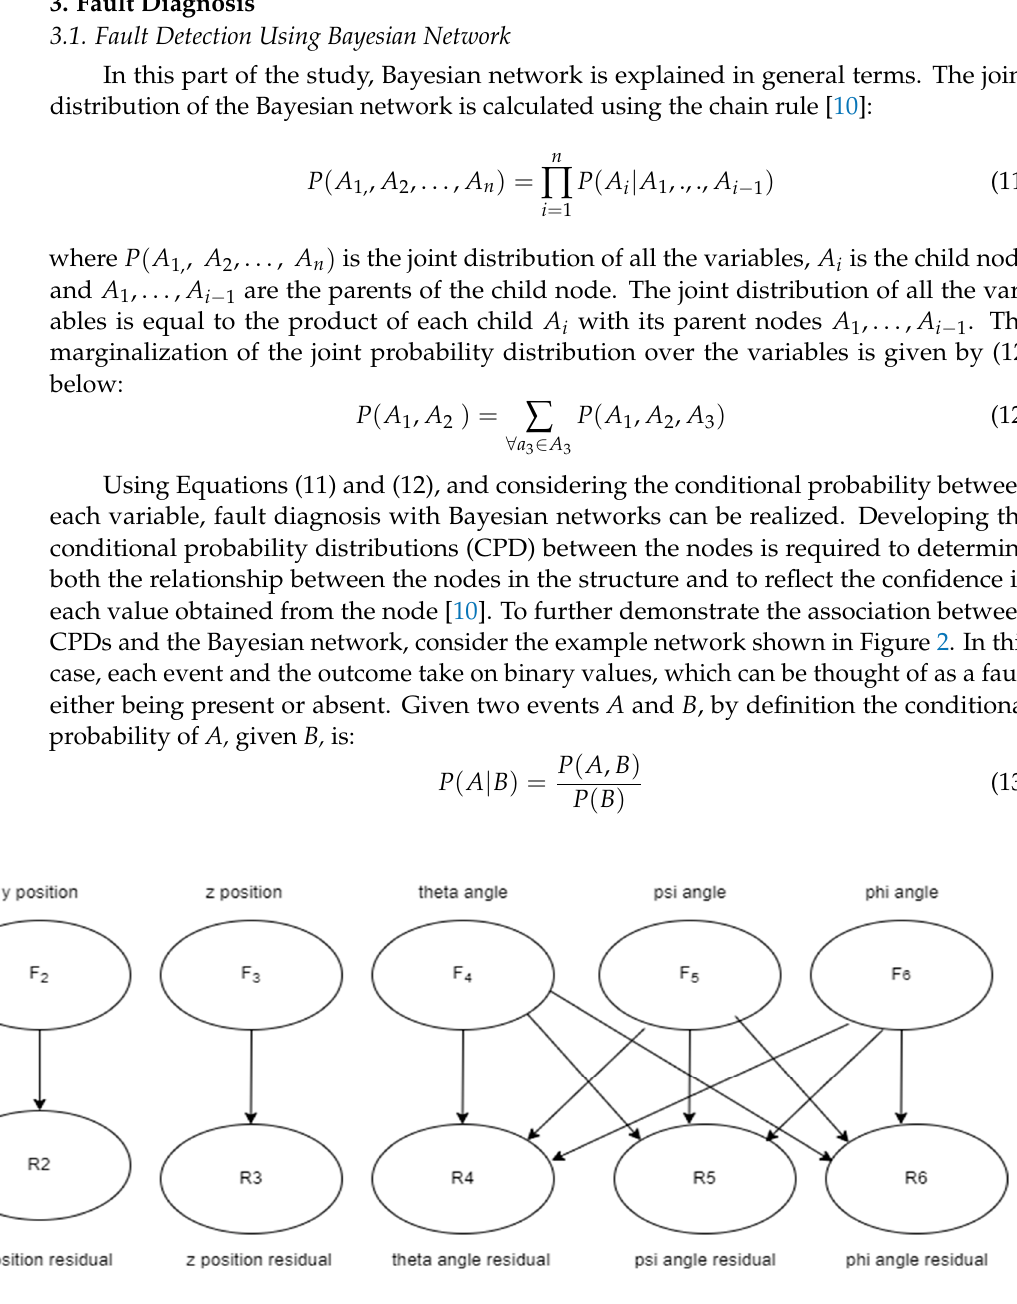
Figure 2. The structure of the